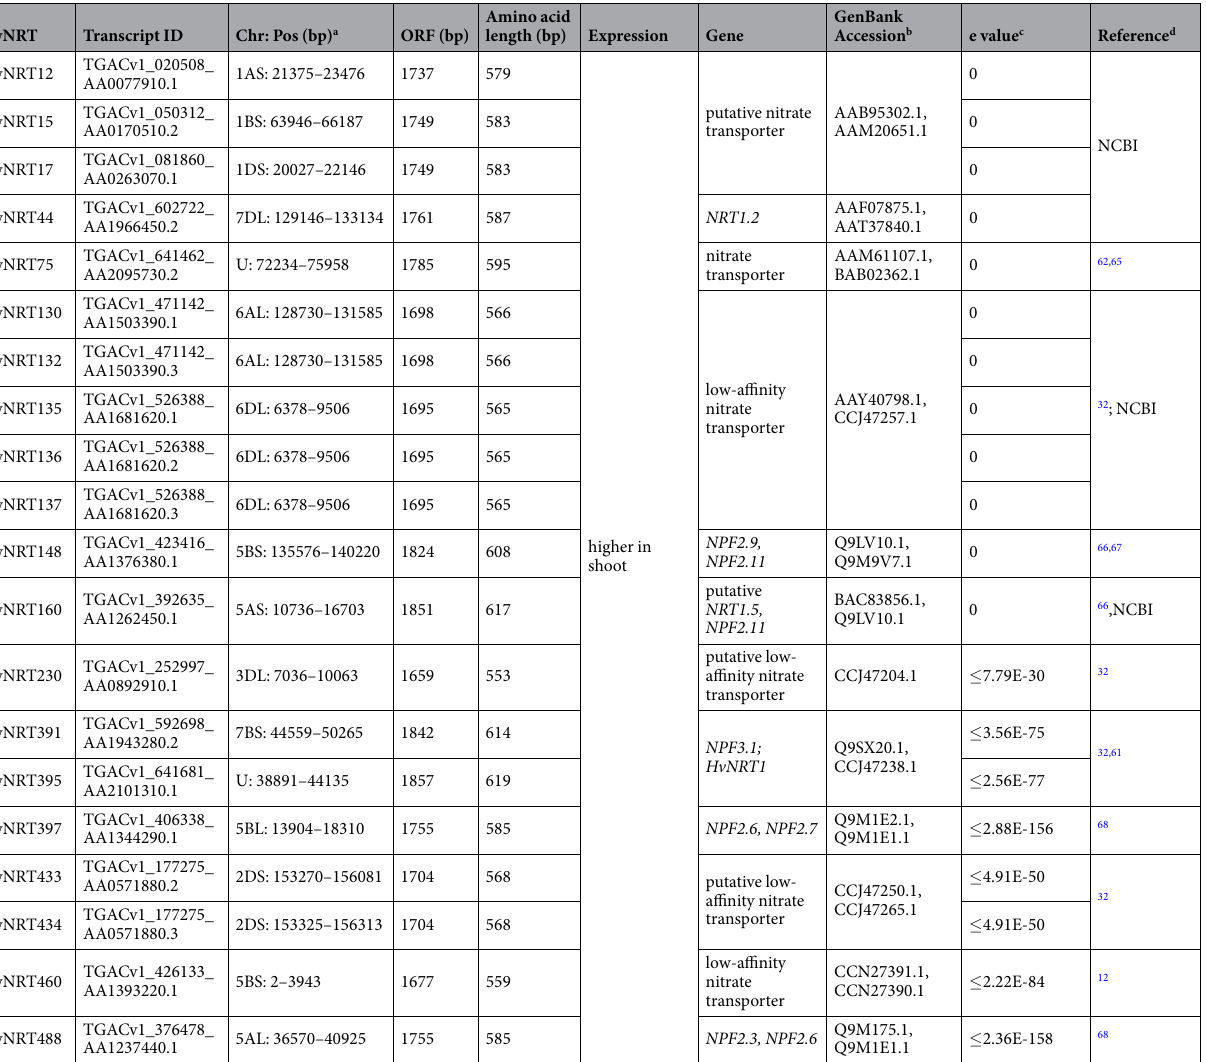
Table 3. Annotation information of differentially expressed nitrate transport genes in root and shoot of five wheat seedlings. a Chromosome labeled ‘U’ indicates an unknown map position for the scaffold housing the corresponding transcript ID. b Only the two best hits from blastx are shown. c The highest value is shown if the blastx results had different e-values. d ‘NCBI’ is listed as the reference for genes that were either unpublished or directly deposited into